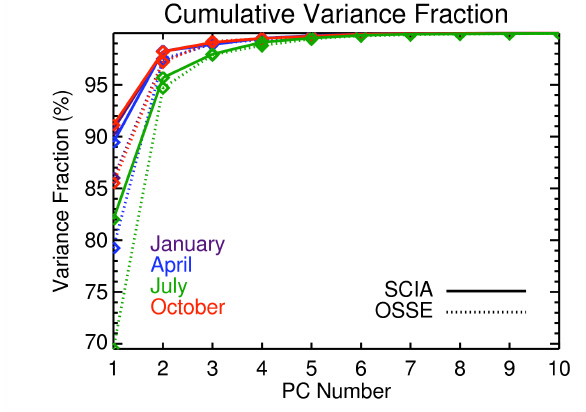
Fig. 3. The cumulative variance fraction for each of the four cases for the first ten PC dimensions. For all four months, both SCIA- MACHY (solid) and OSSE (dashed), six PC dimensions explain be- tween 99.7% and 99.9% of the total data variance in both data